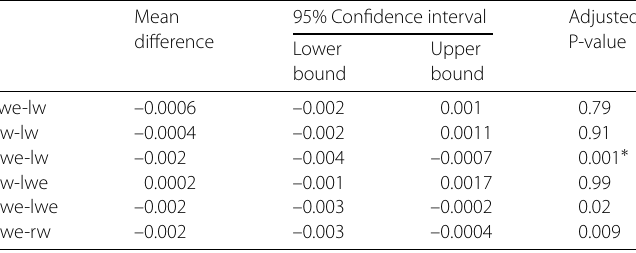
Mean 95% Confidence interval Adjusted difference